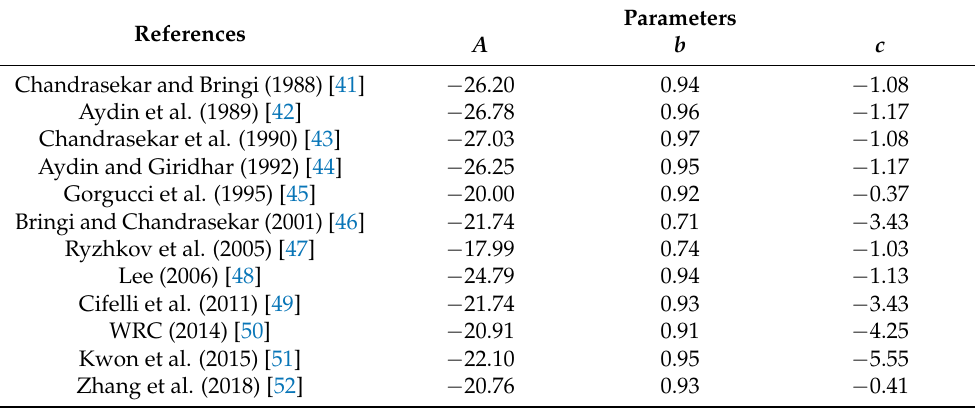
Table 1. Various parameter sets of the dual-pol radar rain rate estimator reported